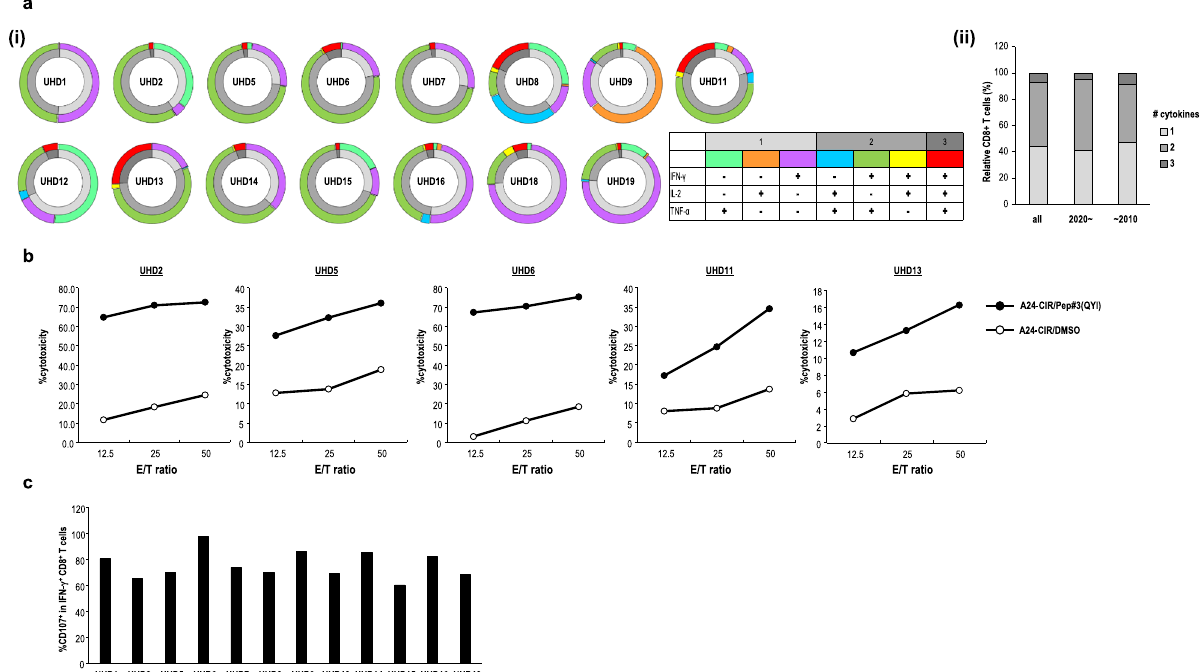
Fig. 2 Function of SARS-CoV-2-speci fi c CD8 + T cells from UHDs. a Polyfunctionality of SARS-CoV-2 Pep#3(QYI)-speci fi c CD8 + T cells. Pep#3(QYI)- speci fi c CD8 + T cell lines were established from UHDs and re-stimulated individually with Pep#3(QYI) in an ICS assay ( n = 15). The frequency of CD8 + T cells with different cytokine production pro fi les (IFN- γ , TNF- α , and IL-2) was determined. (i) The outer ring of the double ring pie shows the cytokine pro fi le in different colors, and the inner ring represents the number of cytokines produced, with gray scale. (ii) The mean of the frequency of number of cytokines produced in UHDs (early 2020) and UHDs (pre-pandemic 2004 – 2010) and all was summarized. b Peptide-speci fi c cytotoxic activity of Pep#3(QYI)-speci fi c CD8 + T cells from representative donors. The cytotoxicity assay was performed in duplicate. Data represent the mean of duplicate. c Frequency of the degranulation marker CD107a positive in Pep#3(QYI)-speci fi c IFN- γ + CD8 + T cells ( n =